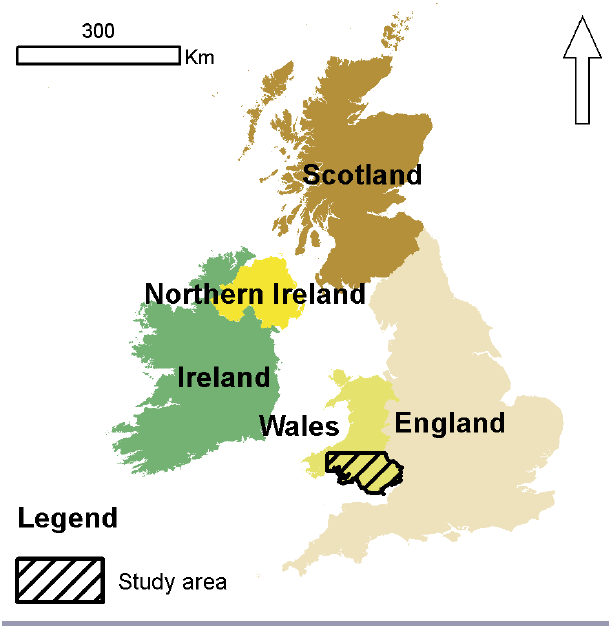
Fig. 1. Location of the South Wales study area in the United